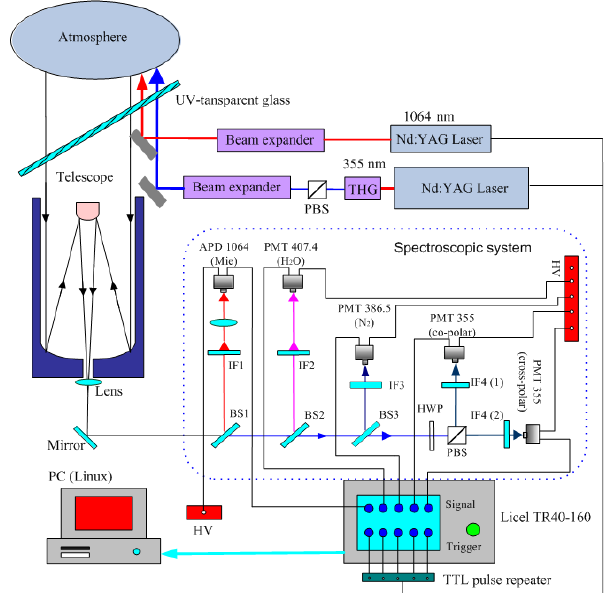
Figure 2. Schematic overview of the five-channel Raman polarization LiDAR system, including the transmitters, receiver, spectroscopic filter, and data acquisition chain. IF: Interference Filter, BS: Beam Splitter, PBS: Polarization Beam Splitter, PMT: Photomultiplier Tube, APD: Avalanche Photodiode, HWP: Half Wave Plate, THG: Third Harmonic Generation, HV: high voltage power